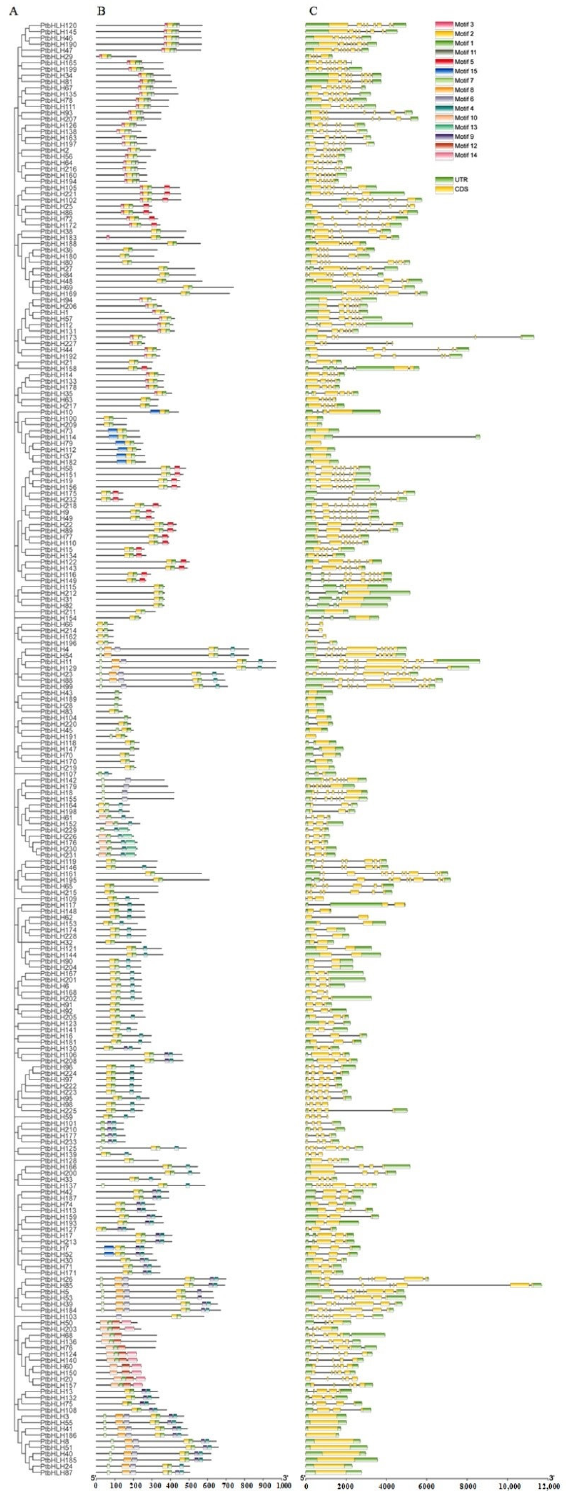
Figure 4. The conserved motifs and gene structure analysis of bHLH gene family in poplar. ( A ) The neighbor-joining (NJ) phylogenetic tree of poplar bHLH genes. The phylogenetic tree was constructed by Mega-X with 1000 bootstraps. ( B ) The conserved motifs analysis of poplar bHLH genes. A total of 15 motifs were predicated by MEME tool, named Motifs 1–15. ( C ) The gene structure analysis of poplar bHLH genes, including UTR, CDS, and intron. The green rectangles represented UTR; the yellow rectangles represented CDS; the grey lines presented